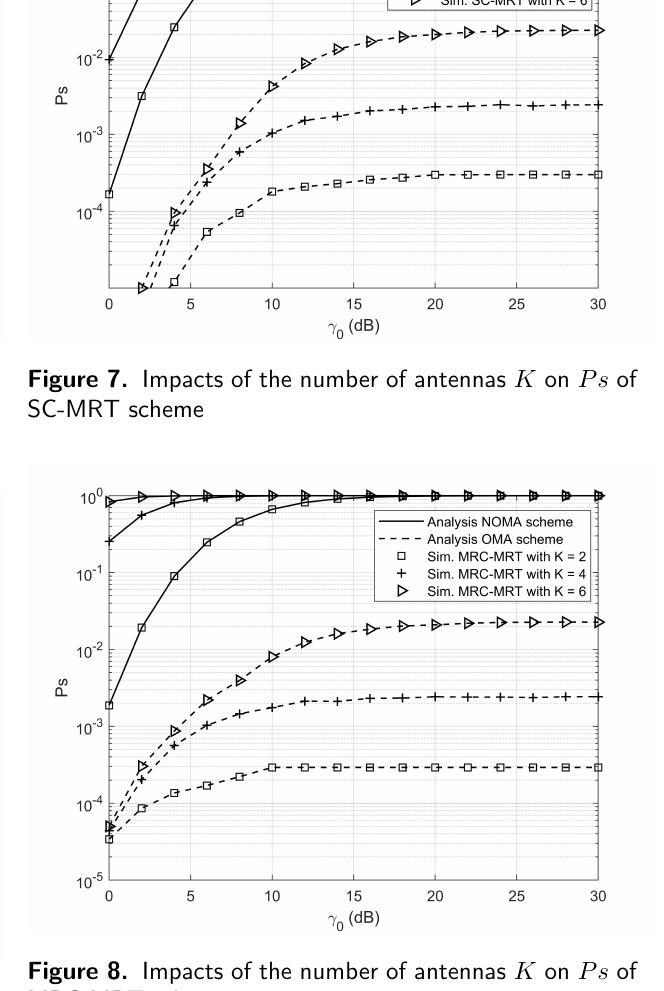
Figure 6. Impacts of the number of antennas K on Ps of MRC-TAS2 scheme